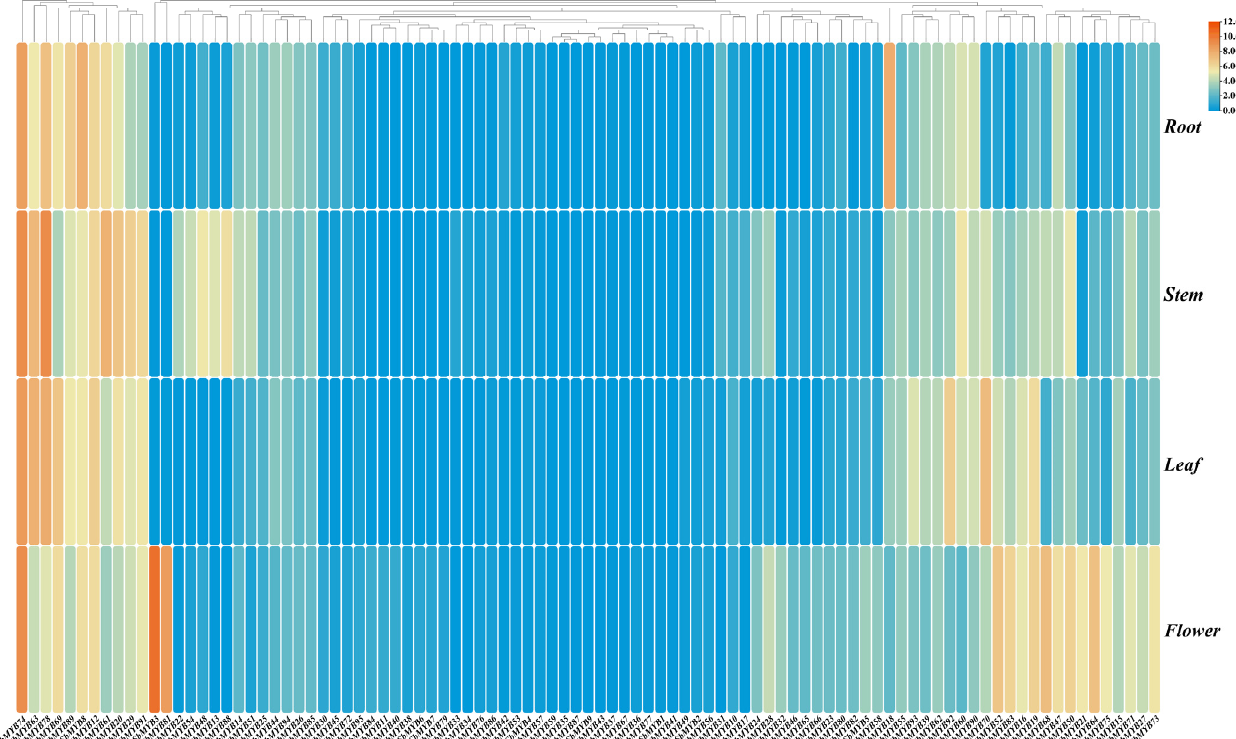
Figure 7. The heatmap shows the hierarchical clustering of expression profiles of R2R3-SbMYB genes in different tissues based on Lg (FPKM) values.